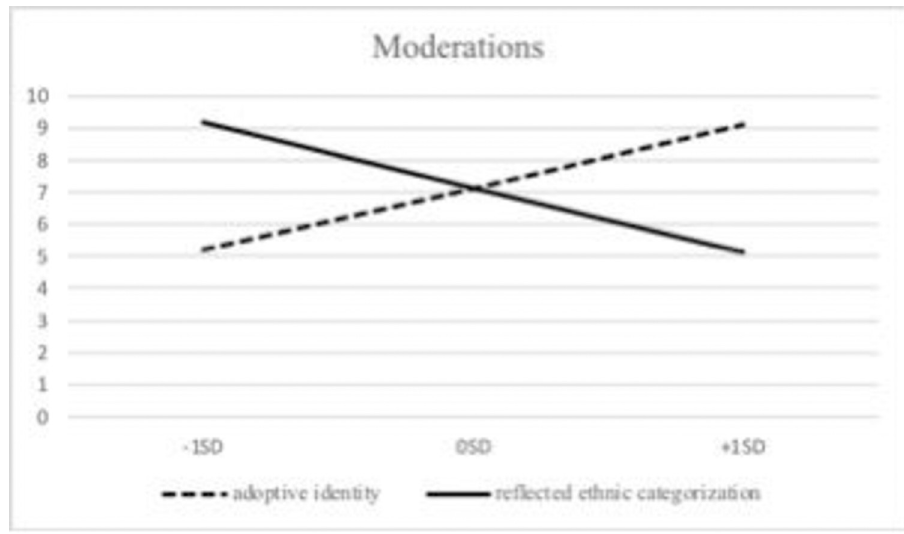
Fig 2. Moderating effect of adoptive identity and reflected minority categorization on the relation between victimization and psychosocial adjustment.